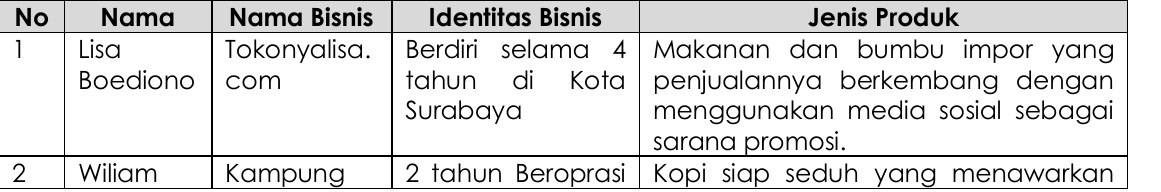
Tabel 3.1. Profil